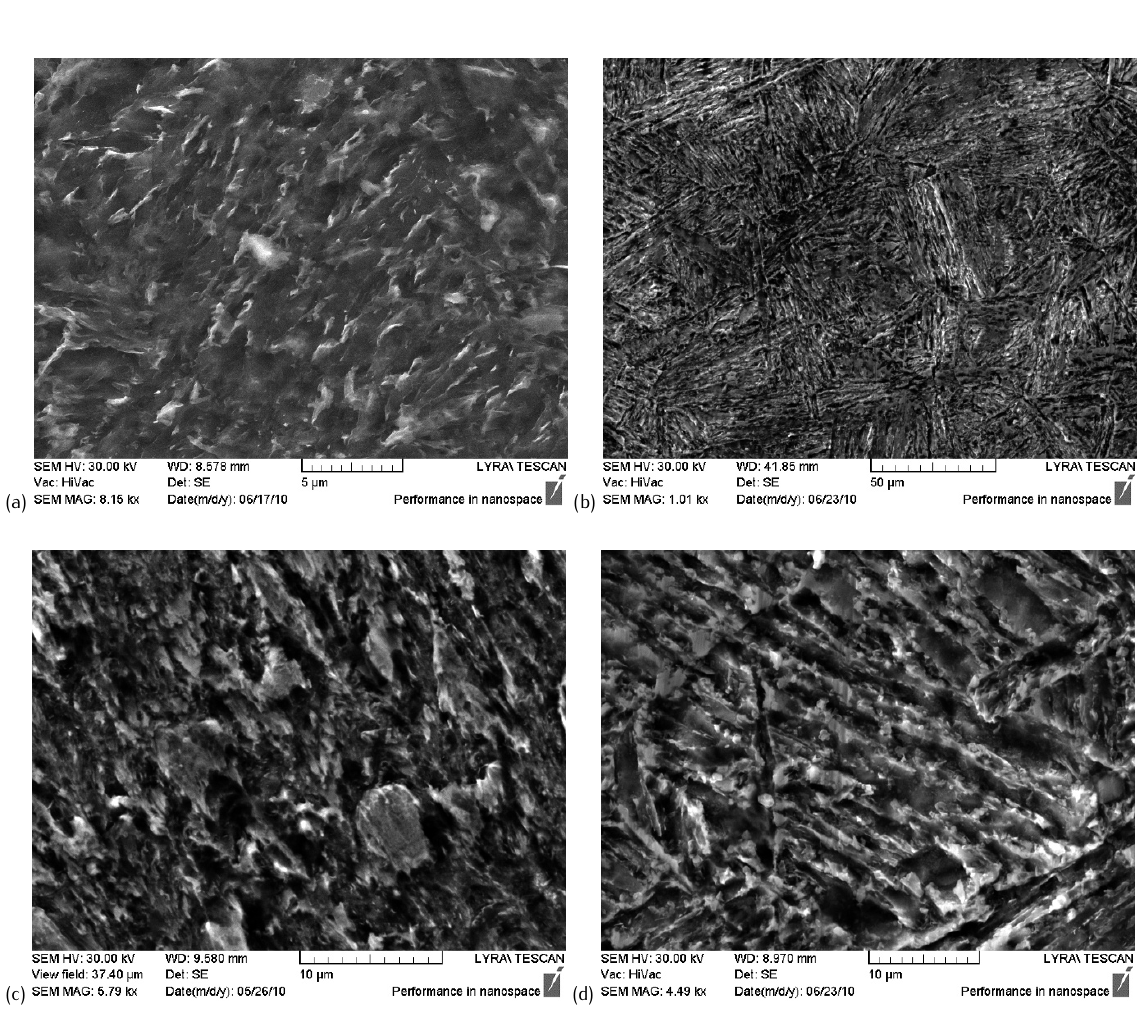
Figure 2. Microstructure of 18CrNi4A (a), (c) and 18Cr2Ni4WA (b,) (d); (a), (b) - immediately cooling; (c), (d) - air